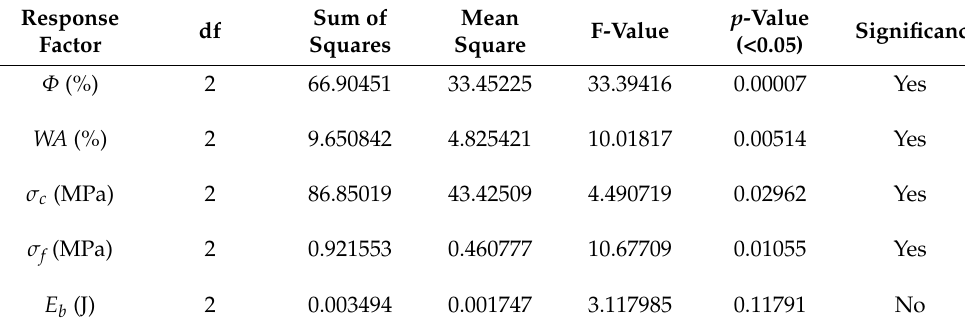
Table 4. ANOVA test results for the effect of RP:RG proportion on various performance